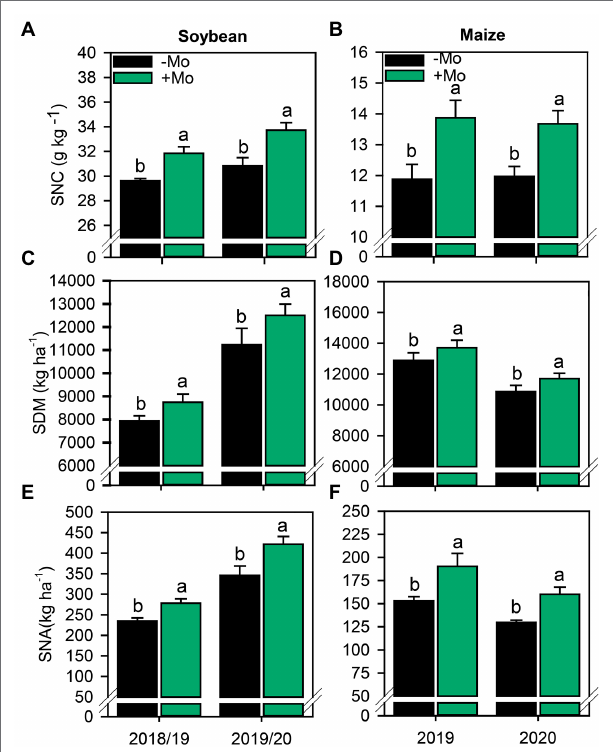
FIGURE 6 | Shoot nitrogen concentration (A,B) , Shoot dry matter (C,D) and Shoot nitrogen accumulated (E,F) of soybean and maize plants as affected by presence or absence of the foliar Mo application. Different lower-case letters indicate significant differences between treatments (presence or absence of Mo supplementation) according to the F test ( p ≤ 0.10). Growing seasons was considered as random